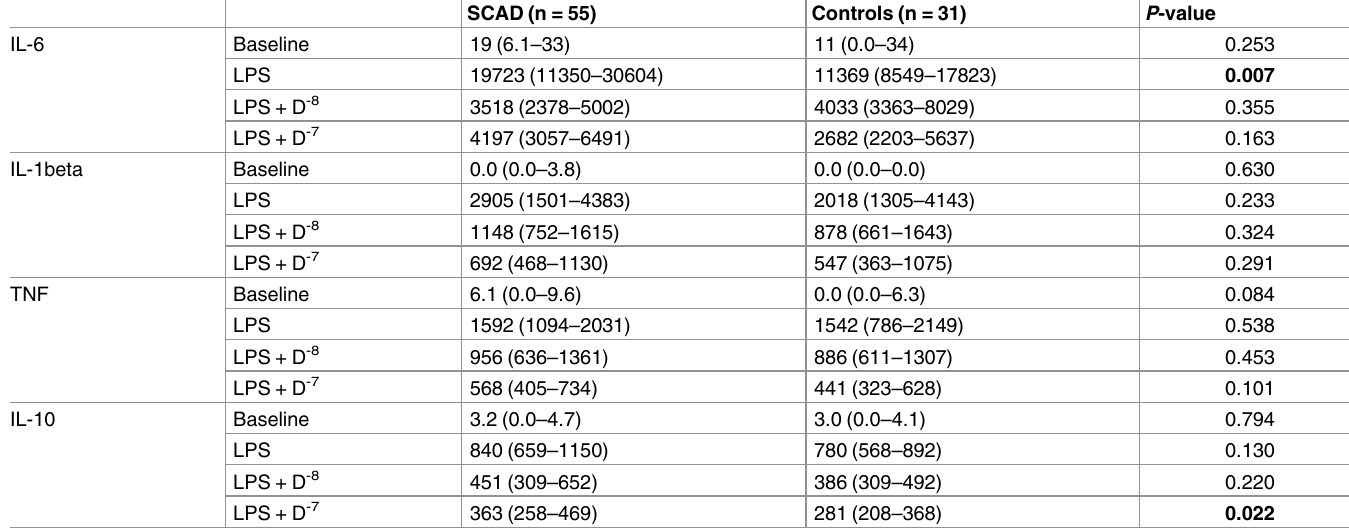
Table 3. Concentrations of IL-6, IL-1beta, TNF and IL-10 (pg/mL) in supernatants of PBMCs from 55 SCAD patients and 31